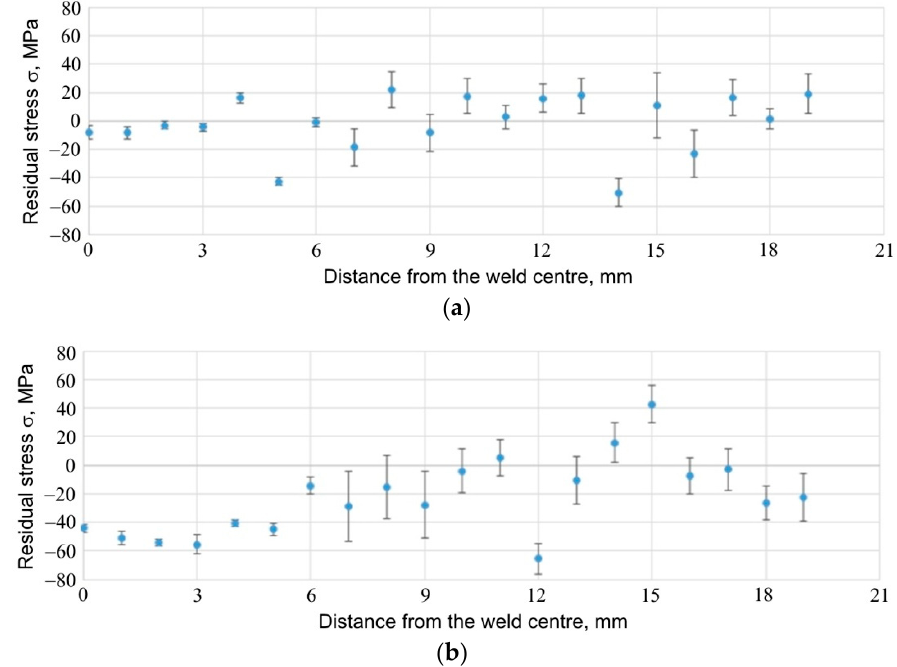
Figure 26. Stresses present in and around the RFSSW joint for specimen E6, for 1.6 mm thick sheet; ( a ) tangential and ( b ) radial component of stresses.